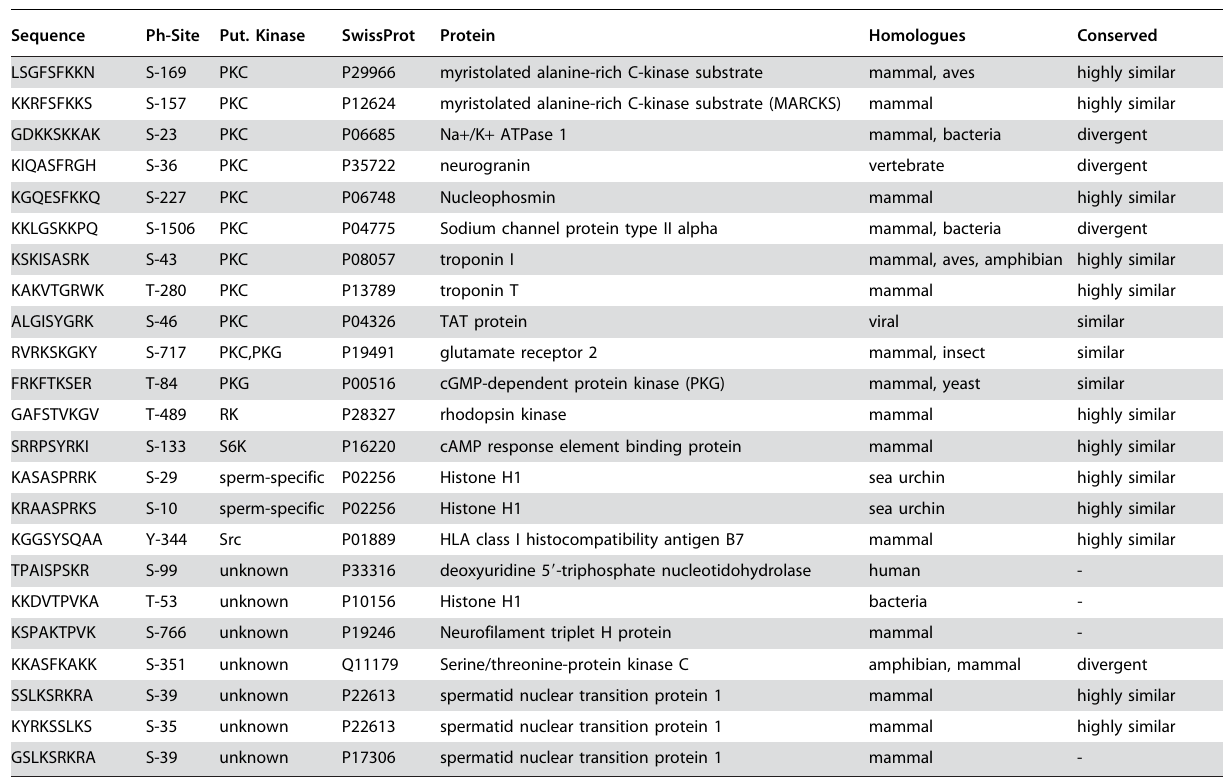
Table S1 Substrates spotted on the PepChip.